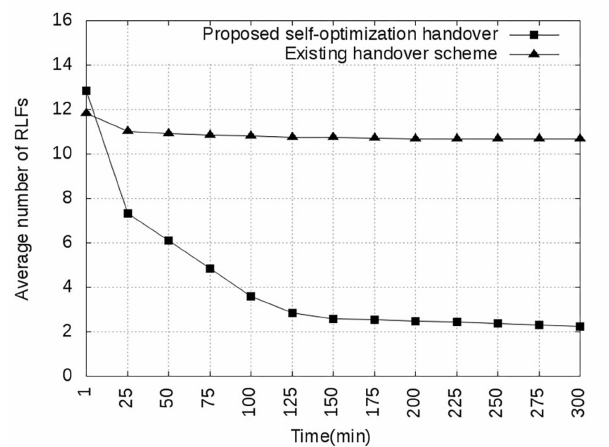
Figure 2. Performance comparison of the proposed self-optimization handover and network-controlled hard HO (NCHH) scheme, the average number of the radio link failures (RLFs) and the fixed mobility pattern with high speed (300 km/h).